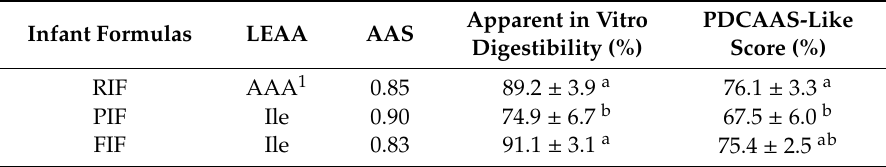
Table 5. Limiting essential amino acid (LEAA), amino acid score (AAS), apparent in vitro digestibility (nitrogen fraction < 10 kDa), and PDCAAS-like score for RIF (reference infant formula), PIF (pea infant formula), and FIF (faba bean infant formula). Data are means ± SD ( n = 3). Di ff erent superscript letters indicate significant di ff erences ( p <